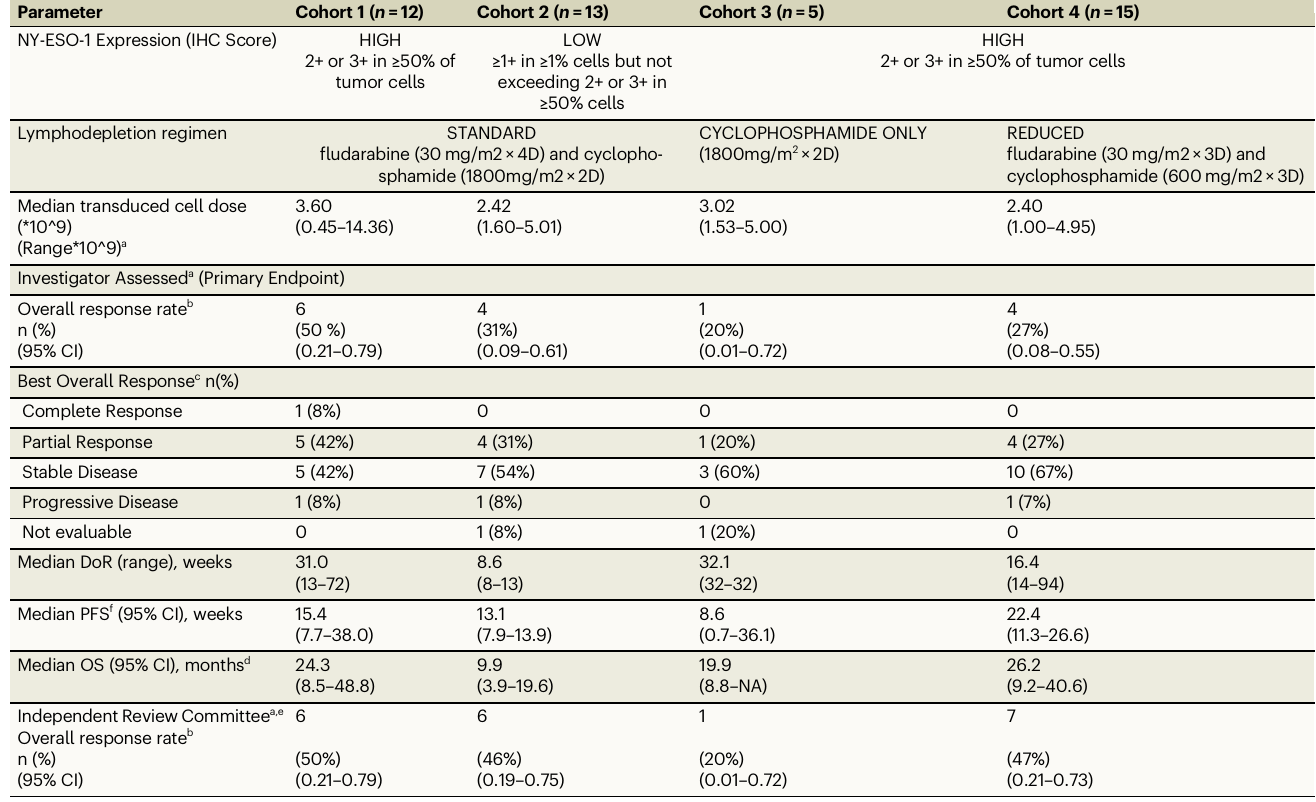
Table 1 | Summary of ef fi cacy results across study cohorts